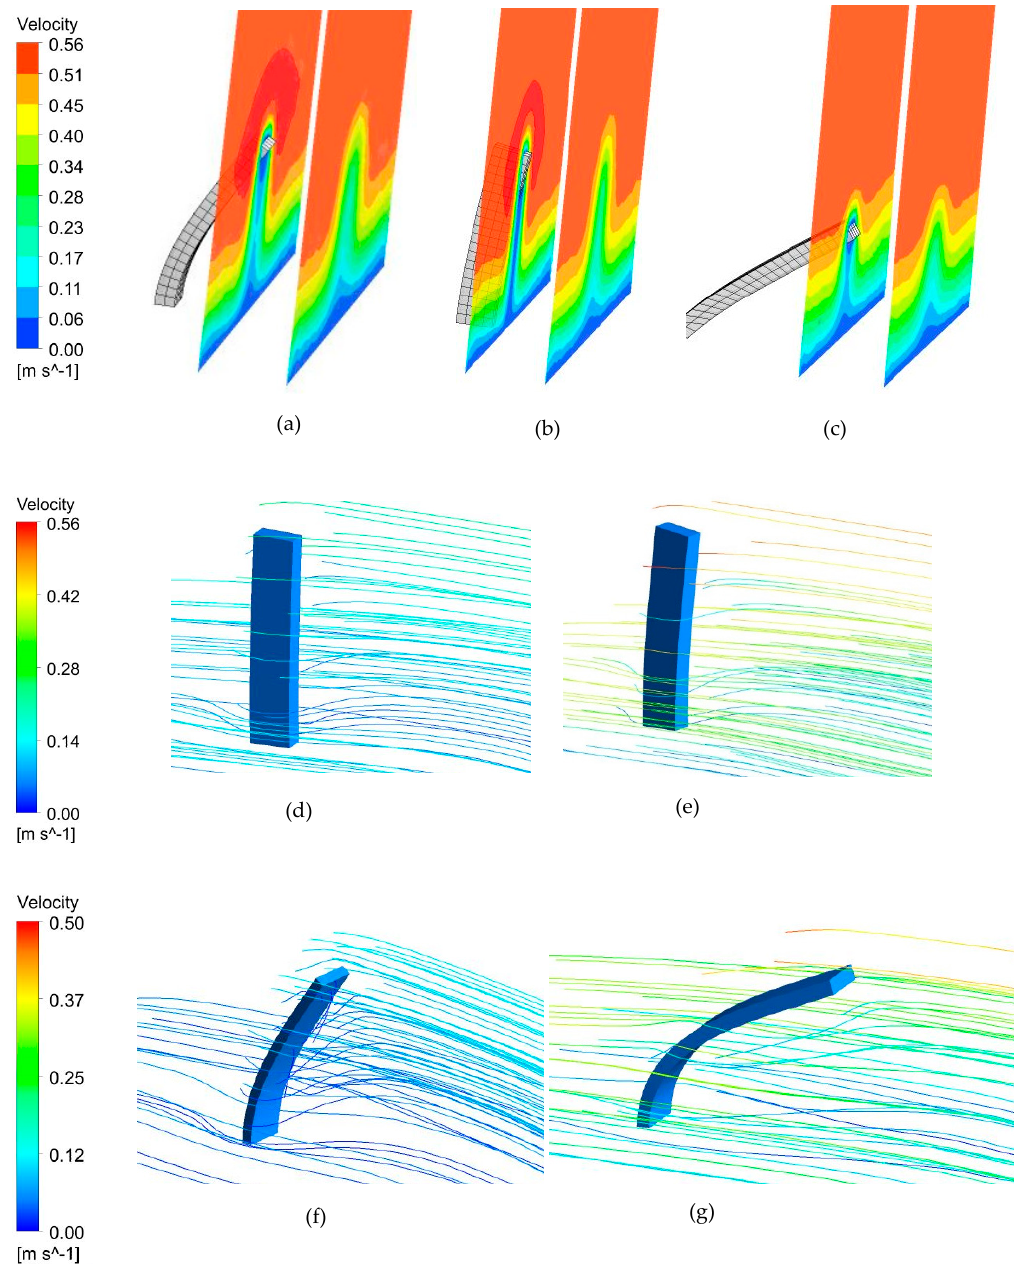
Figure 13. Comparison of flap wake; 10 mm Re = 12 ( a ) angle 0 ° ; (b) 90 ° ; ( c ) Inclined 45 ° ; ( d ) angle 90 ° Re = 6; ( e ) angle 90 ° Re = 12; ( f ) 5mm Re = 3; ( g ) Re = 12.